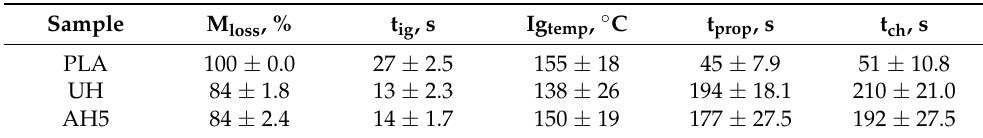
Figure 13. ( a ) Surface temperature(t surf ) and ( b ) temperature transfer through depth(t depth ) of neat PLA, UH, AH5, UHp and AH5p. Table 4. Specimen’s mass loss, ignition time, temperature transfer through depth, basic protection time and start of char time.